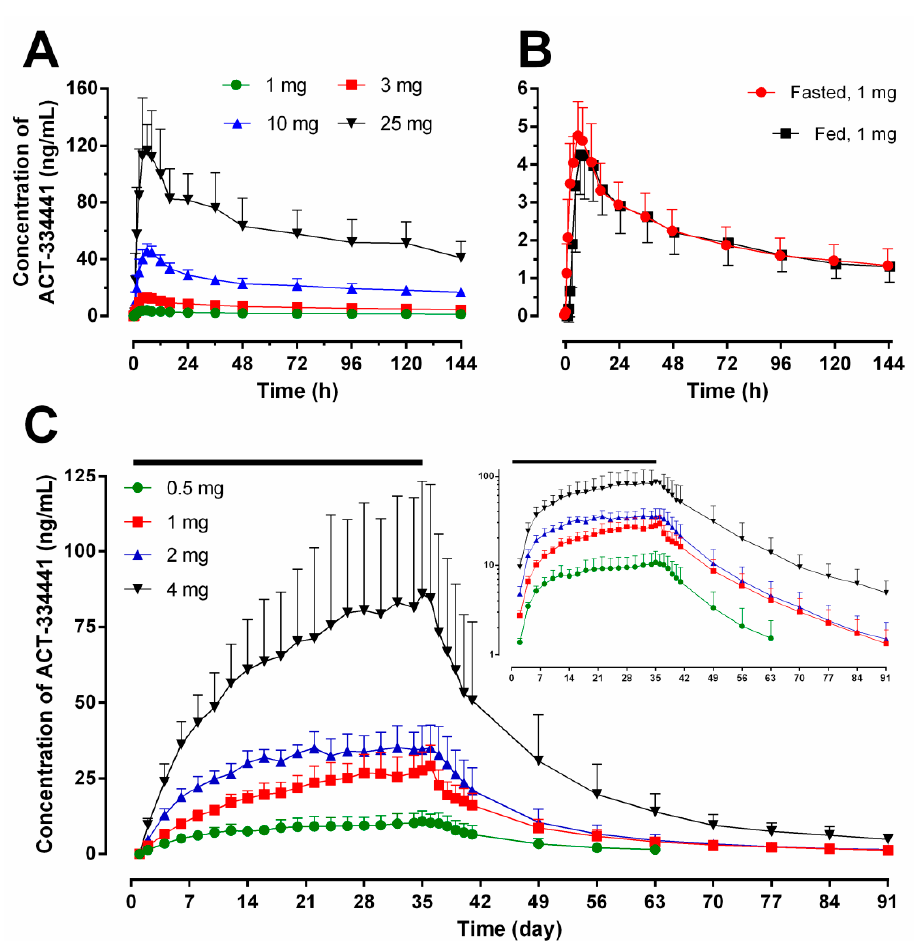
Figure 1. Arithmetic mean (with standard deviation) plasma concentration-time profiles of cenerimod following single or multiple o.d. oral doses in healthy subjects. Panels ( A , B ) represent the concentration of cenerimod after single ascending doses ( N = 6 per dose group) and single-dose administration in fasted versus fed conditions (1 mg, N = 8), respectively; Panel ( C ) depicts the concentration of cenerimod until the end-of-study (EOS) ( N = 6 per dose group, the black bar represents the treatment duration of 35 days) on linear scale (semi-logarithmic scale shown as inset).